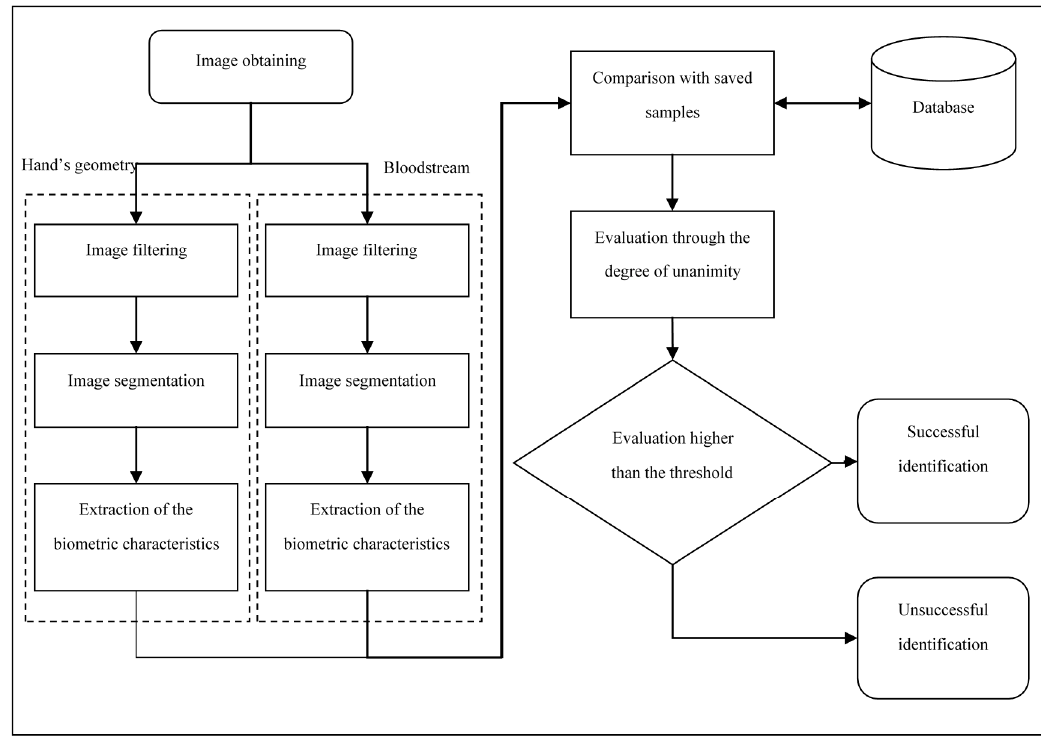
Figure 1. Schematic representation of the proposed identification and verification system.